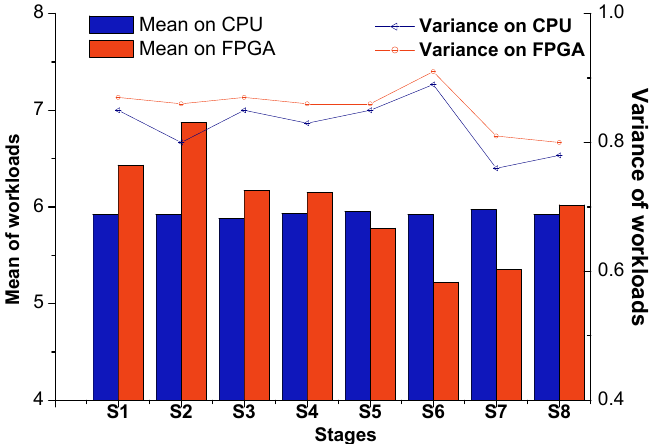
Figure 10. Comparisons of workload distributions of d-left hashing implemented on CPU and FPGA.